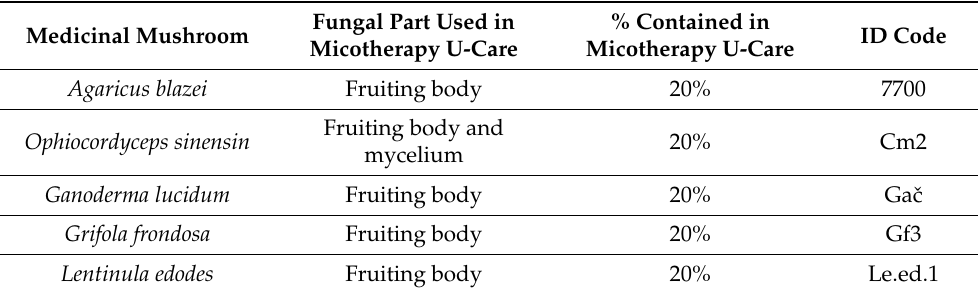
Table 1. Details on Micotherapy U-care supplement composition.